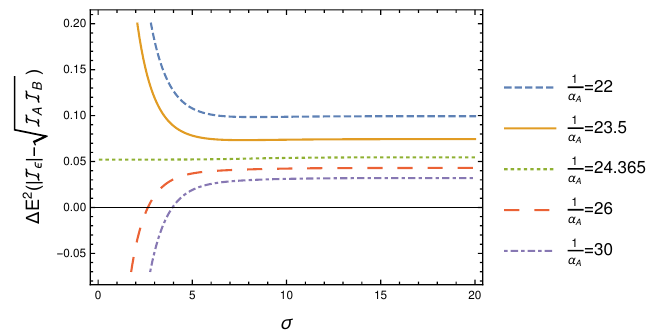
√ (cid:0) (cid:1) is plotted for two anti-parallelly Figure 12 . In (1+3) dimensions the quantity ∆ E 2 |I ε | − I A I B accelerating detectors with respect to the inverse temperature of the thermal bath σ for different fixed accelerations α , and α is fixed at α = 1 . Here the set of fixed α is different than the A B B A ones considered in figure 11. However, here also one can observe a transition in the nature of the curves as α changes. A